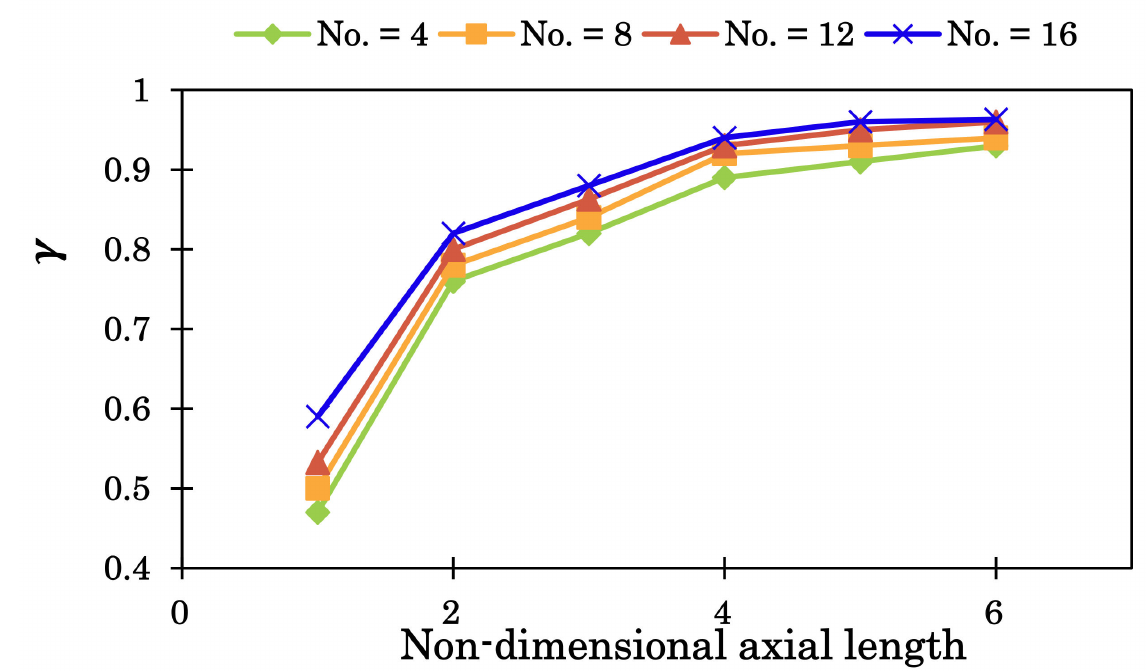
Figure 8. Variation of γ along the combustion